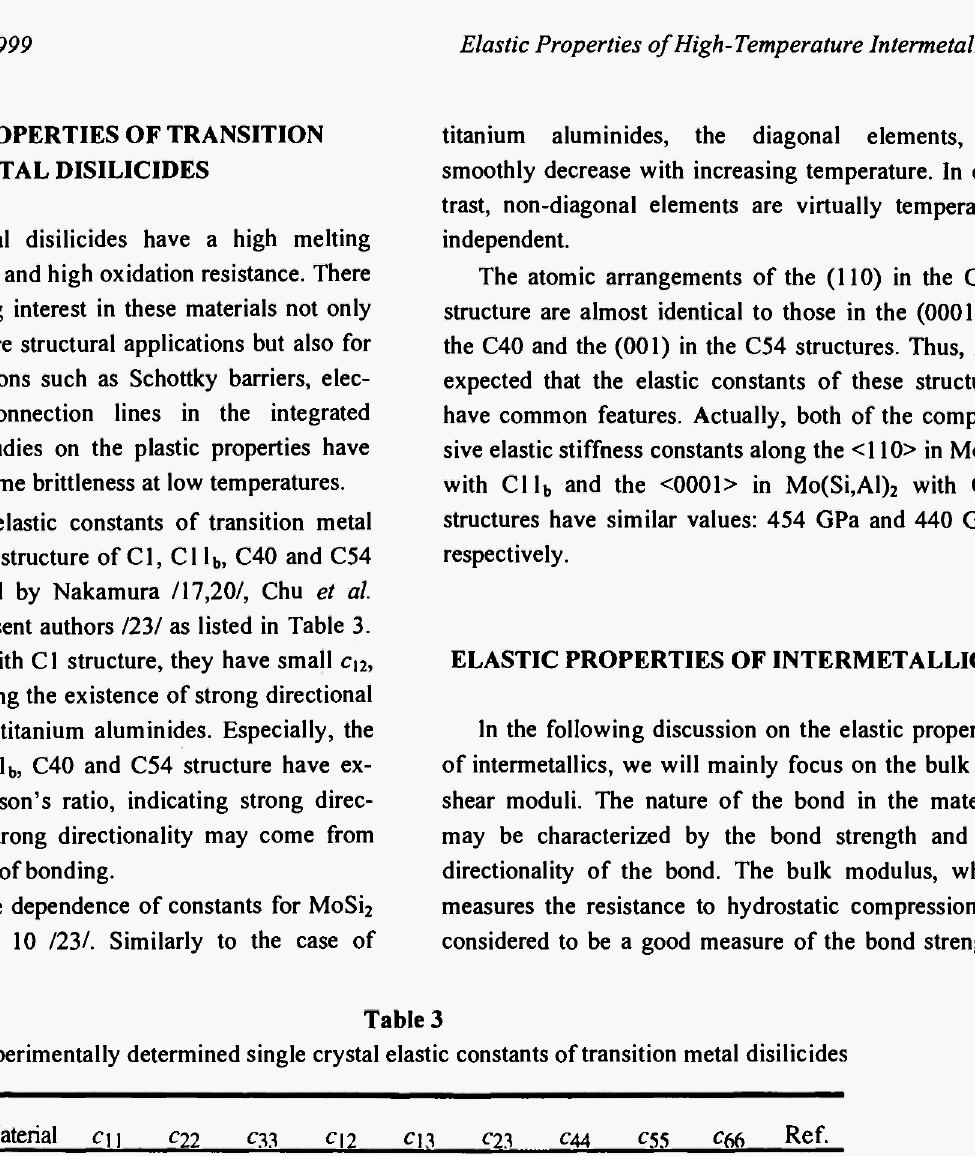
Experimentally determined single crystal elastic constants of transition metal disilicides